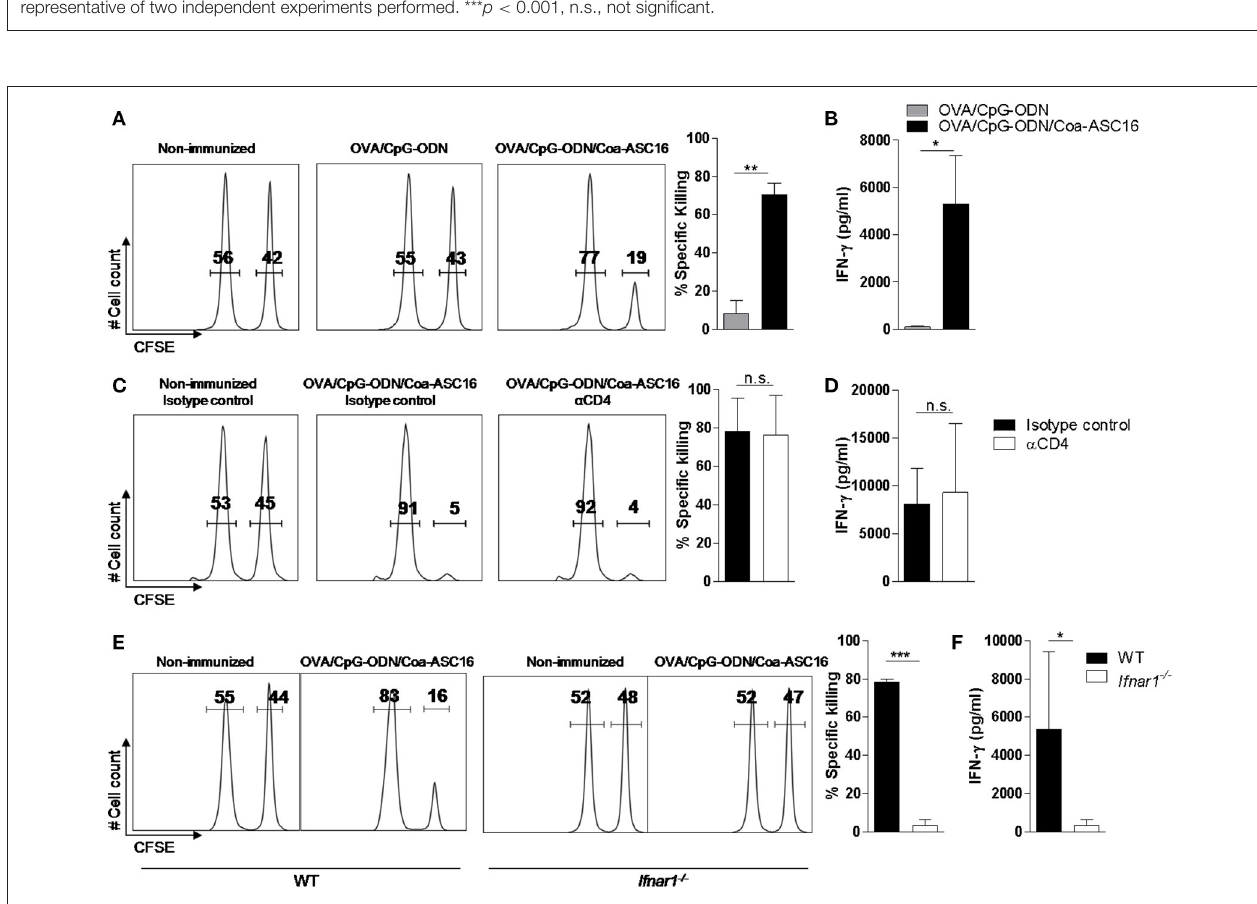
FIGURE 5 | CD8 + T-cell response elicited by the nanostructured formulation is CD4 + T-cell independent and IFN-I dependent. WT (A–D) or Ifnar1 − / − (E–F) mice were immunized with a single-dose (day 0) of the indicated formulations. (A,C,E) In vivo killing assay and (B , D and F) ex vivo IFN- γ secretion by splenocytes after stimulation with SIINFEKL peptide determined by ELISA on day 7. In C and D , mice were treated on days − 2, − 1, 0, and 2 with anti-CD4 or isotype control (IgG) antibodies. The data show the mean ± SEM of individual values (3-4 mice/treatment group in each experiment) and are representative of two independent experiments performed. n.s., not significant, * p < 0.05, ** p < 0.01, *** p < 0.001.